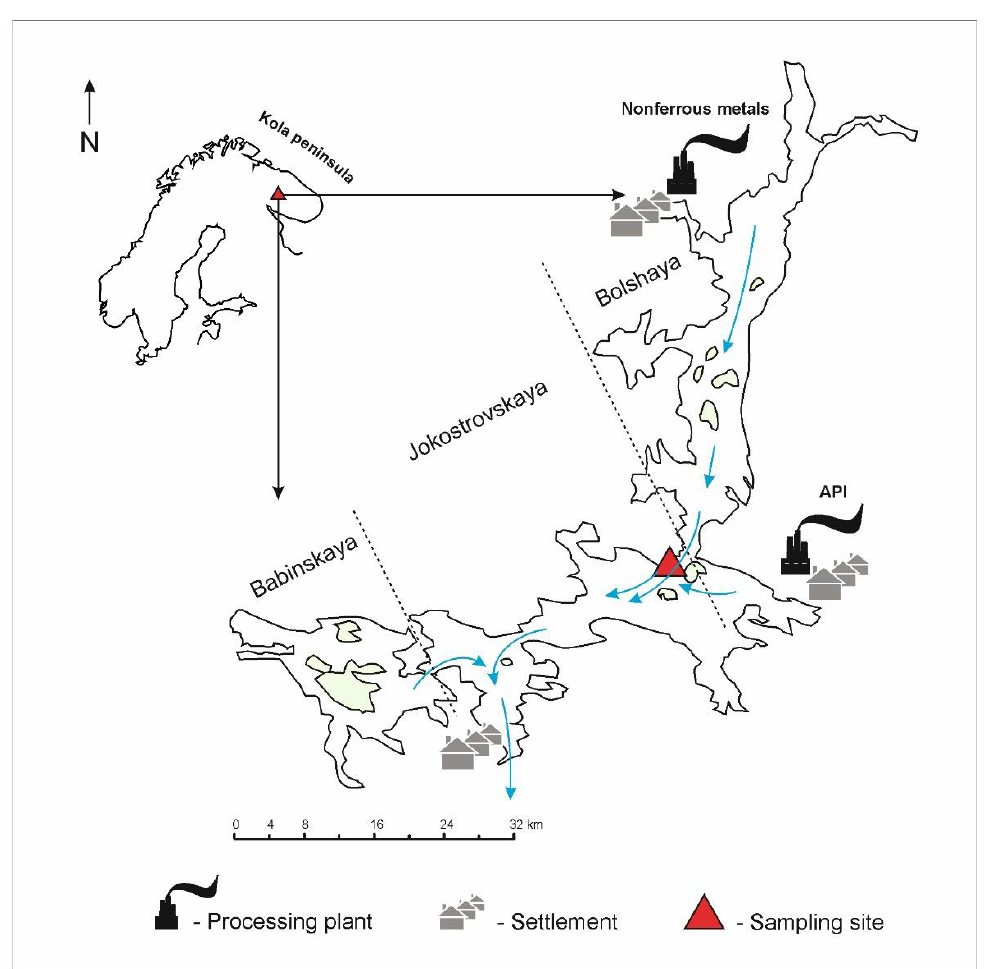
Figure 1. Study area and location of the sampling site (67.595249 N; 33.003494 E). Blue arrows indicate directions of the currents in the Lake Imandra. API — apatite processing industry. Dashed lines indicate approximate borders of the parts of the lake.